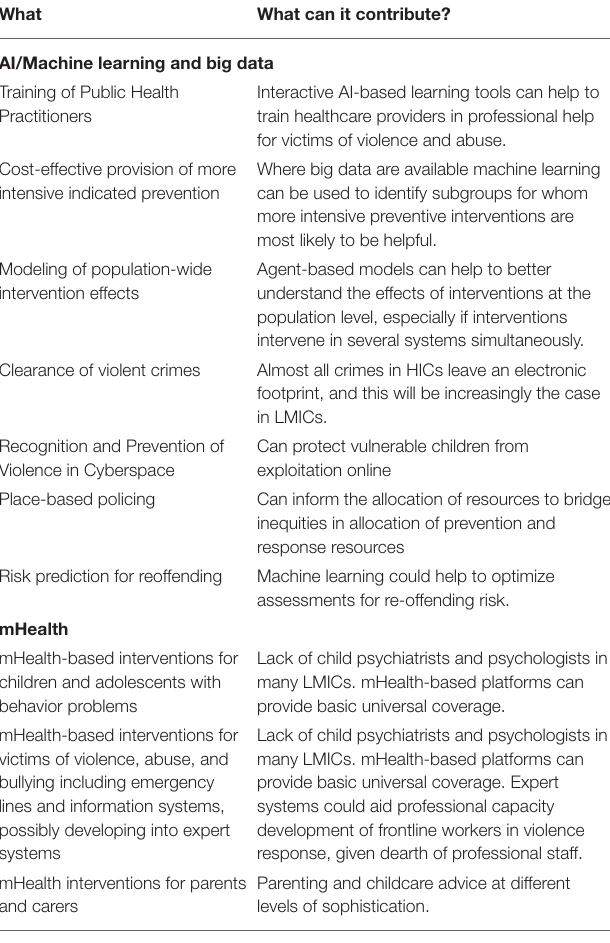
TABLE 1 | Mapping the possible contributions of AI, machine learning, Big Data, and